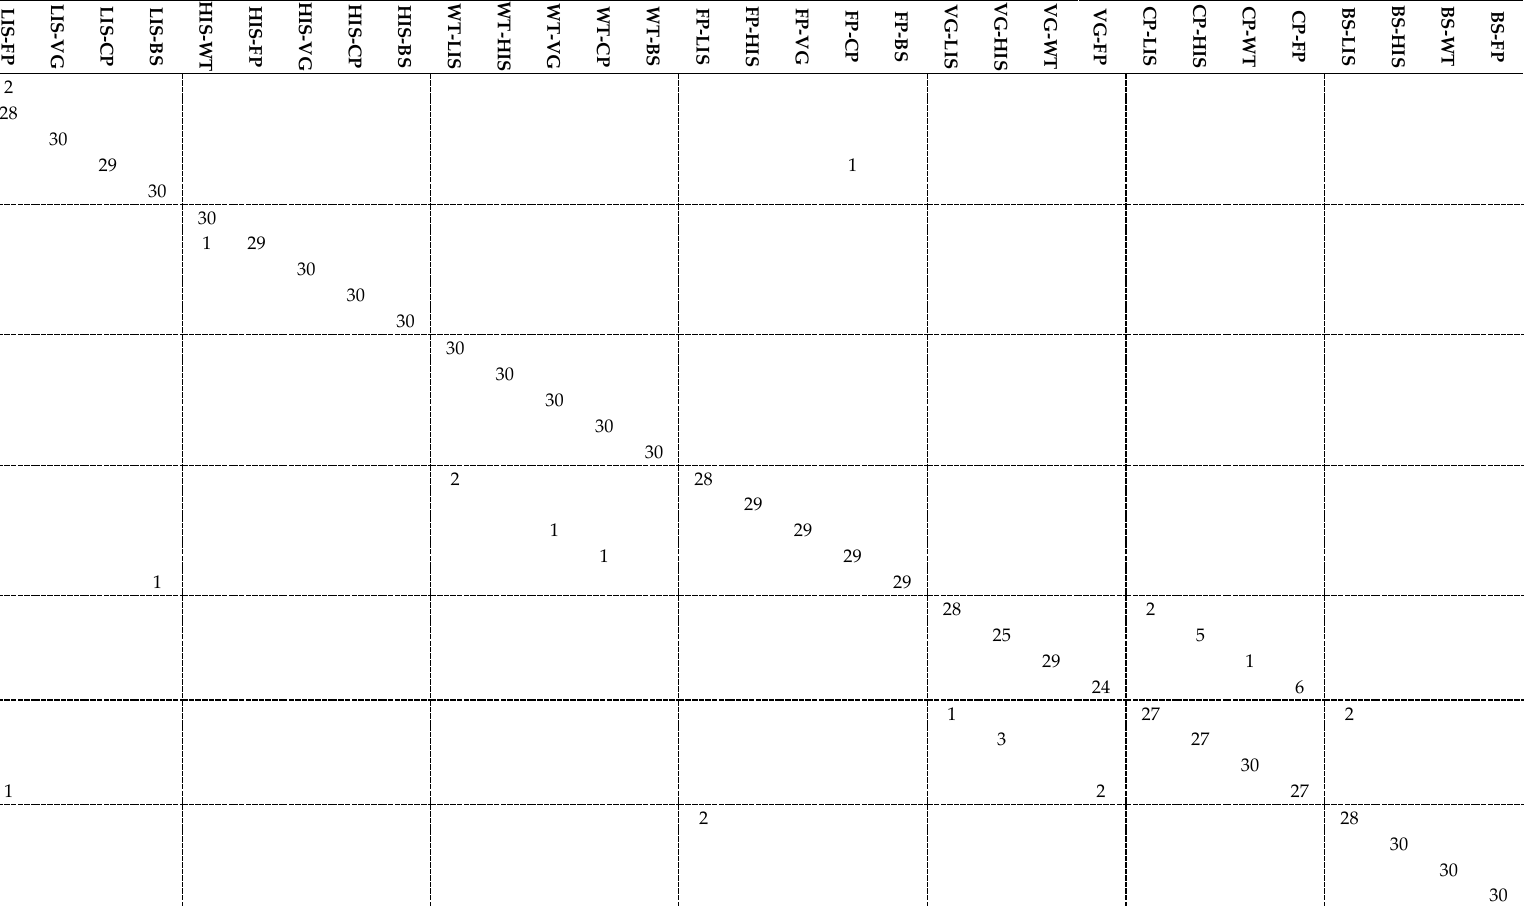
Table 3. The correspondence matrix of observed change classes (rows) and predicted change class